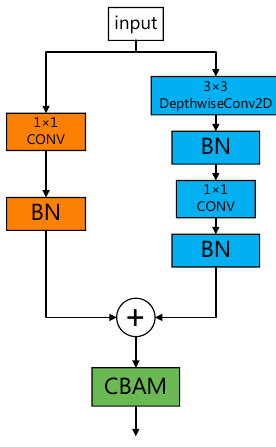
Figure 8. Structure of improved ParNet block.